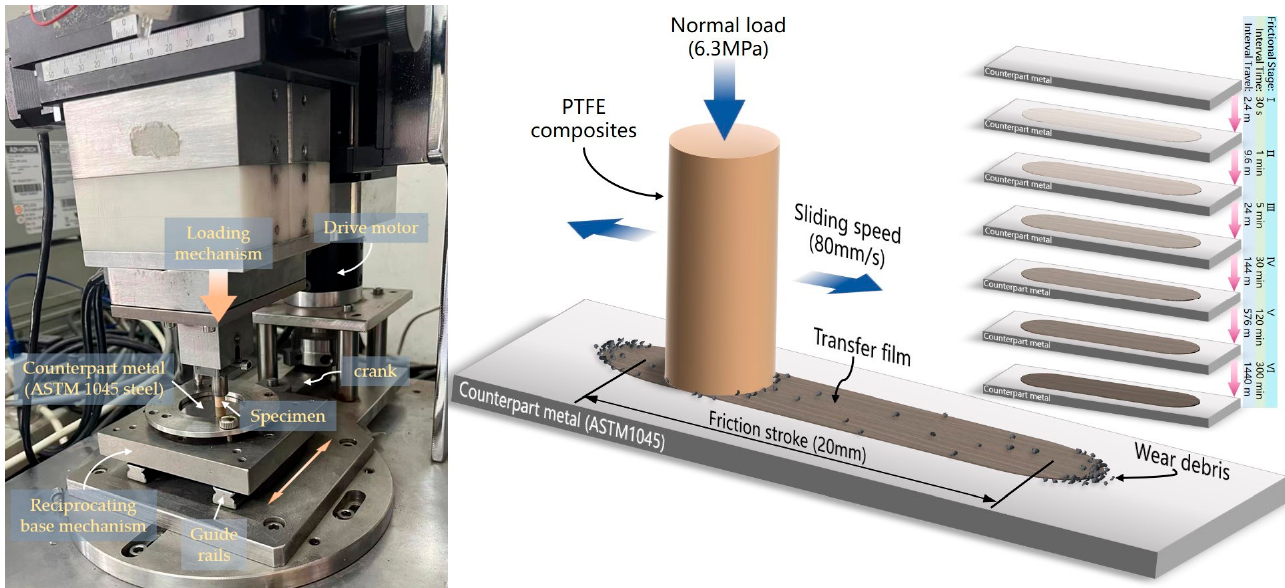
Figure 1. Schematic diagram of PTFE composite reciprocating friction test.